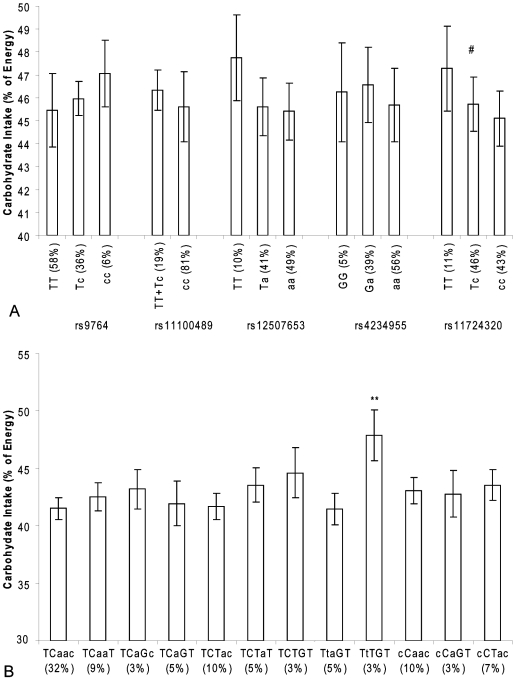

NPY1R/NPY5R variants and carbohydrate intake in the Hamlet population.Figure 2a shows the association of SNPs in the NPY1R/NPY5R region with carbohydrate intake as percentage of total energy intake. The ancestral alleles are indicated as capital letters. # p<0.01 for trend. Figure 2b shows the association of NPY1R/NPY5R haplotypes with carbohydrate intake as percentage of total energy intake. The haploblocks consist of the SNPs rs9764, rs11100489, rs12507653, rs4234955 and rs11724320 and the ancestral alleles are indicated as capital letters. **p<0.01 (compared with linear regression model).